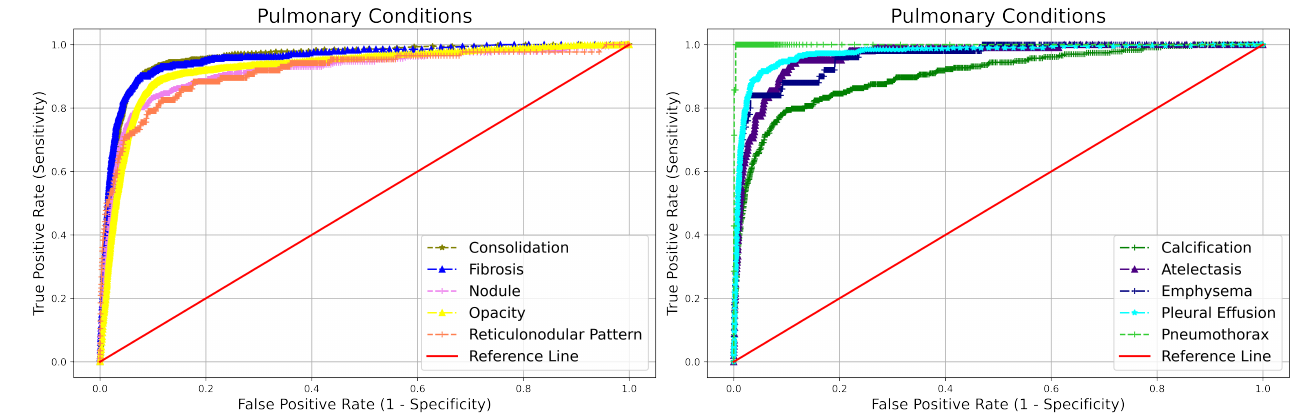
Figure 5. ROC curve qXR performance in identifying subabnormality from abnormal CXR and categorizing into pulmonary conditions.